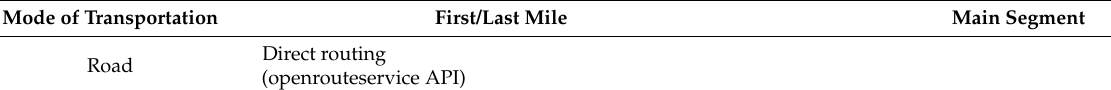
Table A1. Overview on Model